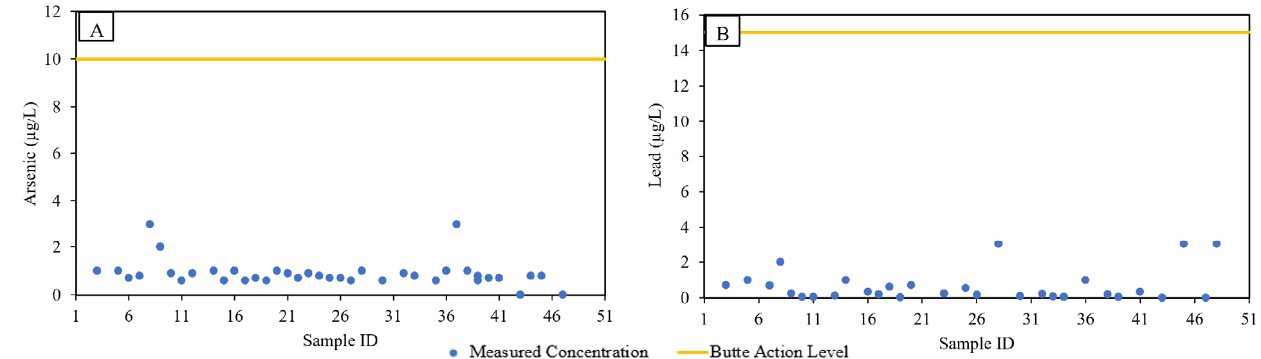
Figure 3. Butte residential drinking water As and Pb concentrations. ( A ) Drinking water As concen- trations; ( B ) Drinking water Pb concentrations.